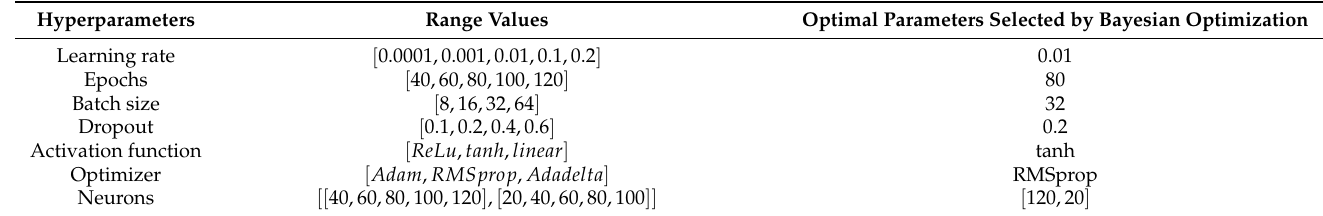
Table 1. Set of hyperparameters spaces for LSTM and GRU Models.